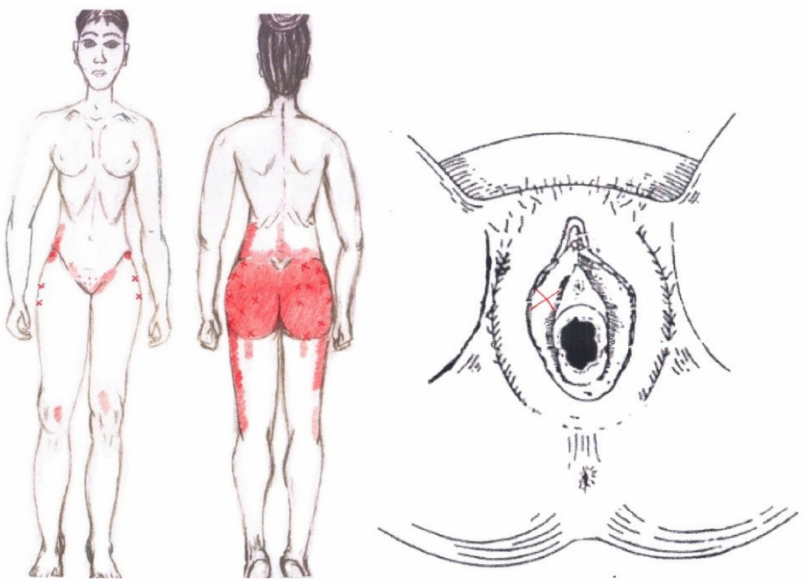
Figure 9. Graphical simulation of referred pain areas of the gluteus medius